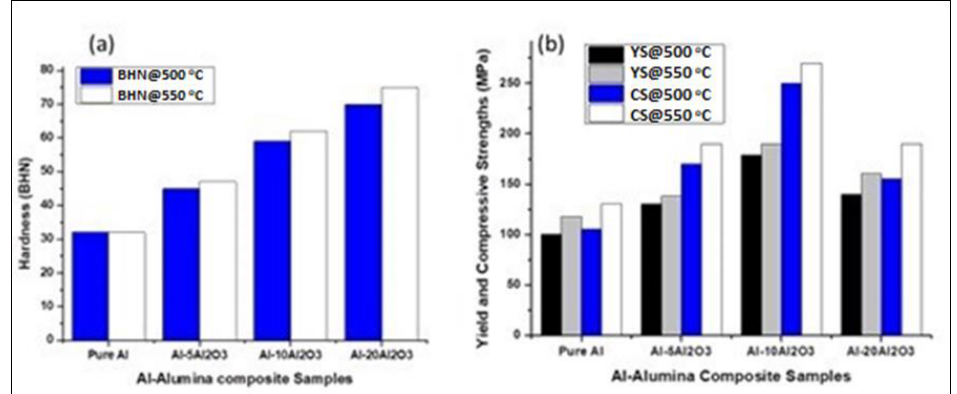
Figure 2. Profiles of ( a ) hardness, ( b ) yield and compressive strengths of Al-alumina composite samples adapted from [49]. samples adapted from